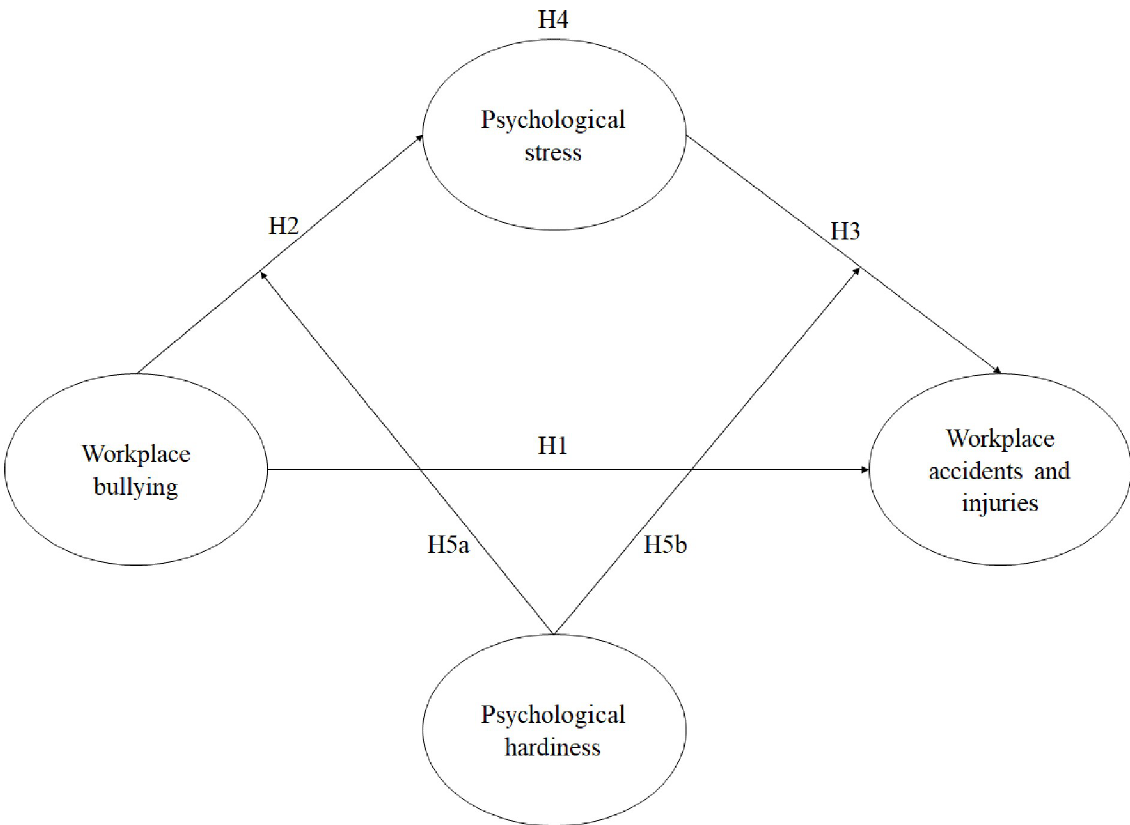
Fig 1. Proposed moderated mediation model. Note : Control variables: tenure, gender, supervisory role, age and marker variable (social desirability), Study 1: Hypotheses 1 to 4, Study 2: Full model (Hypotheses 1 to 4 and moderation hypotheses).